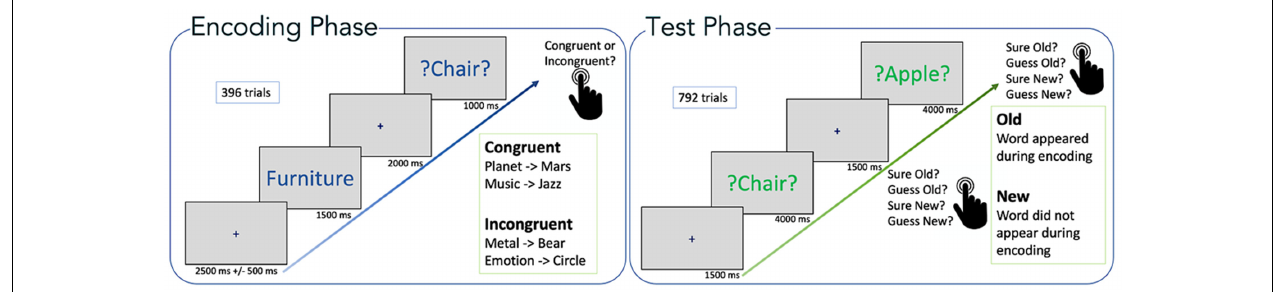
FIGURE 1 | Experimental paradigm. Encoding phase: word pairs are shown (semantic category + target word). Test phase: all target words from the encoding phase were presented randomly intermixed with novel distractors (new words). Figure adapted from Packard et al. (2020).